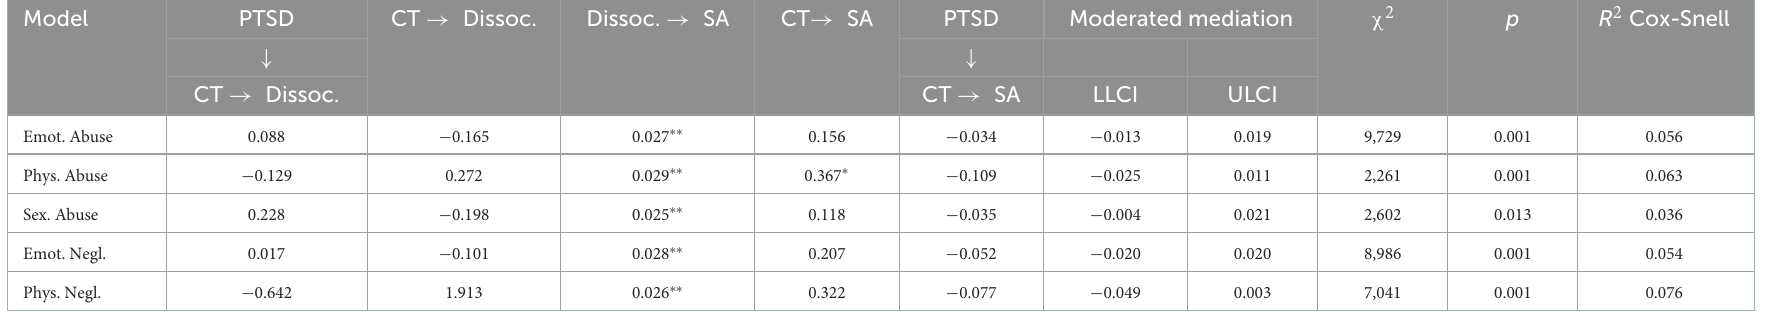
TABLE 3 Analysis of moderated mediation in the relationship between early childhood traumsa and any suicide attempt. Model PTSD CT → Dissoc.